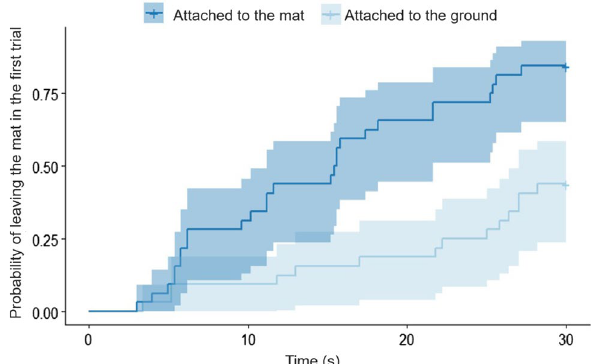
Figure 2. The cumulative occurrences of leaving the mat in the first trials of ’Attached’ and ‘Attached to the mat’